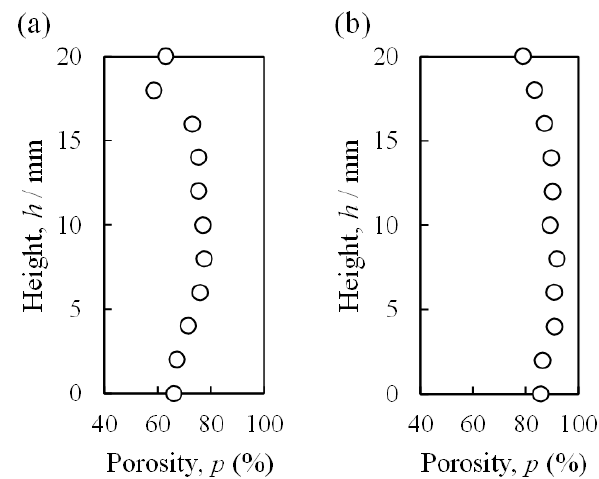
Figure 7. Porosity distributions in the height direction of Al foam-filled steel tube compression test specimens with ( a ) p = 79.3% and ( b ) p = 90.2% corresponding to Figure 5c,d, respectively.